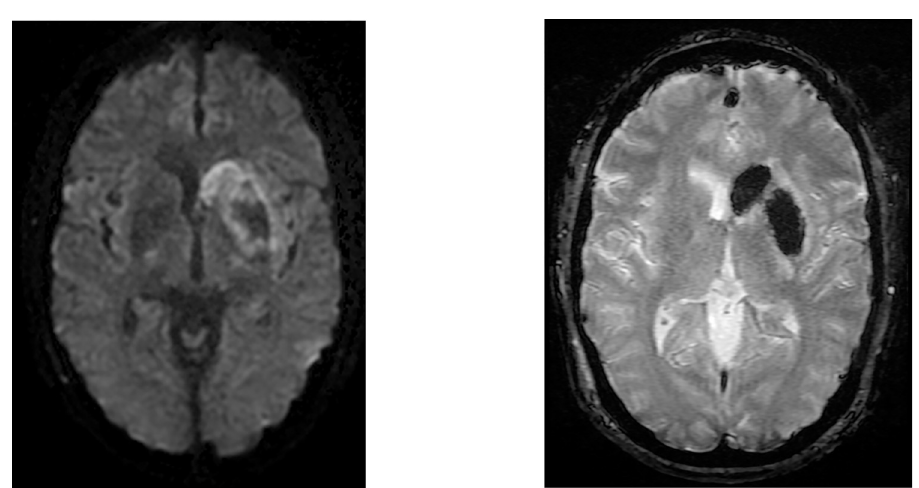
Fig 1. Imaging findings in a 54 y.o. female COVID-19 patient with an endometrial carcinoma who was not receiving ventilatory support. An acute infarct in the left basal ganglia is shown in the DWI image on the left. The heterogeneous signal pattern through the infarct bed is explained in part by the axial gradient echo image on the right, which shows susceptibility through much of the same territory implicating hemorrhage conversion.